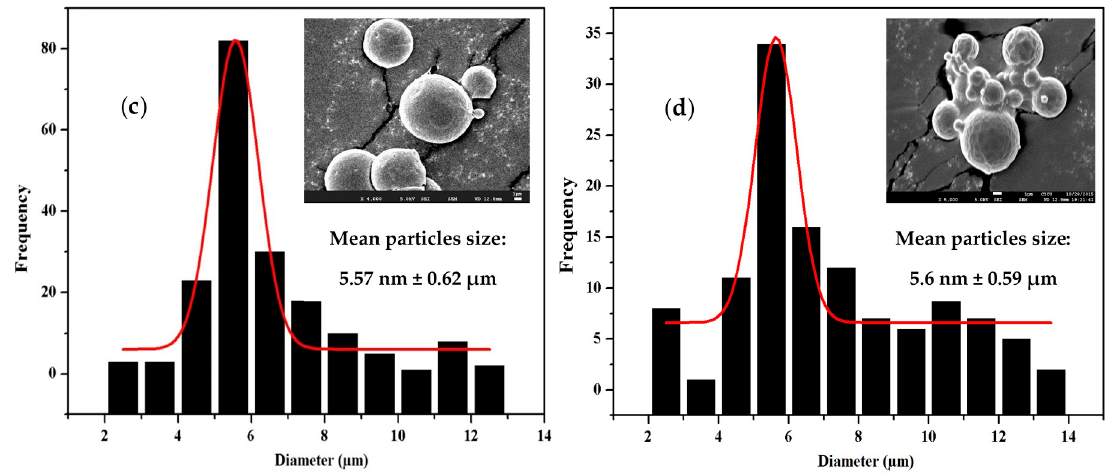
Figure 4. Morphology, particles size, and distribution of ( a ) PLGA 0.49 -(CD-EG) 0 , ( b ) PLGA 0.53 -(CD-EG) 15 , ( c ) PLGA 0.49 -(CD-EG) 15 , and ( d ) PLGA 0.85 -EG 15.